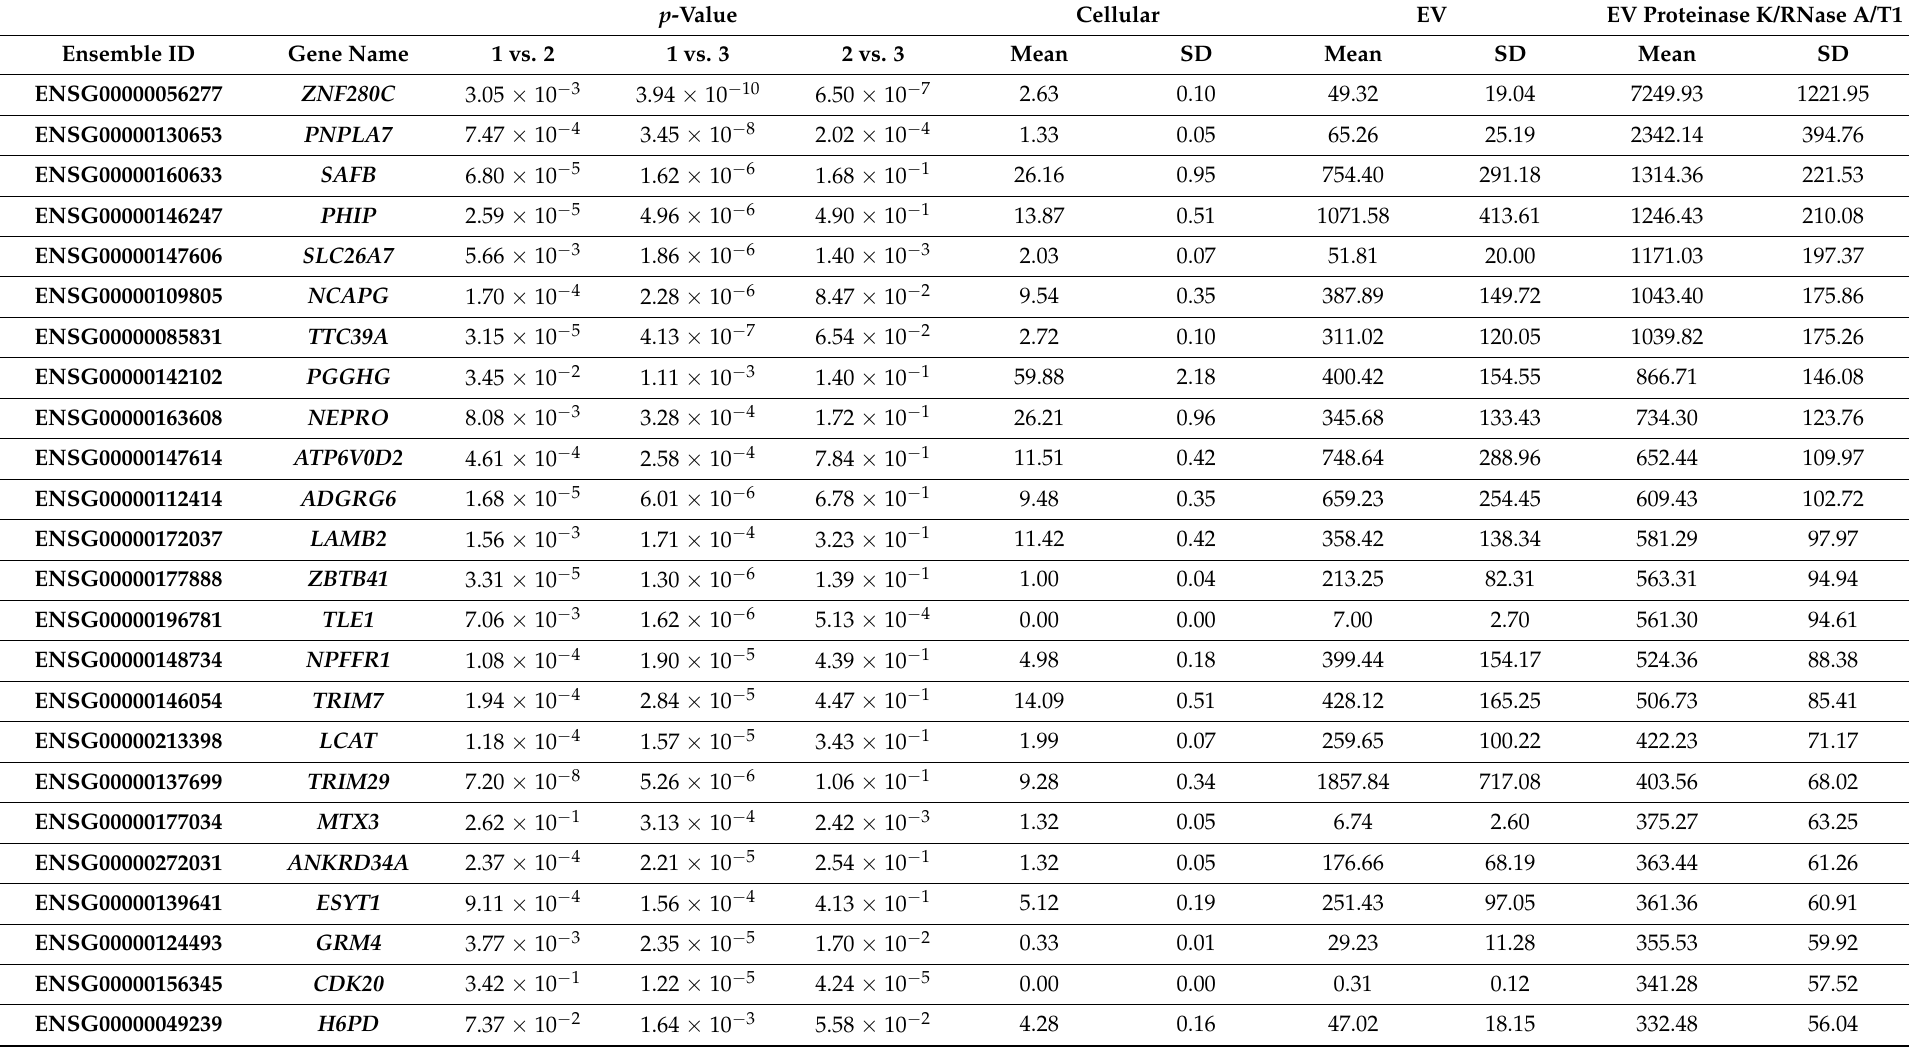
Table 3. Protein-coding RNA significantly different between at least two groups. Group 1: cells, group 2: EV, and group 3: EV proteinase K/RNase A/T1. p -Value Cellular EV EV Proteinase K/RNase